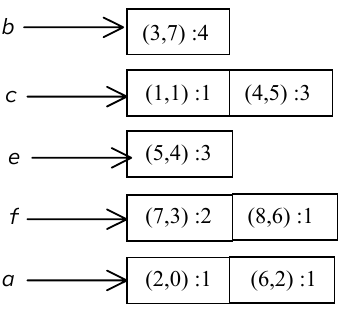
Fig.2. The Node-lists of frequent items in Example 1 Property 2 Given any two different nodes N N , which represent the same item ( N 2 N . item-name ), if N 2 N . post-order < N 1